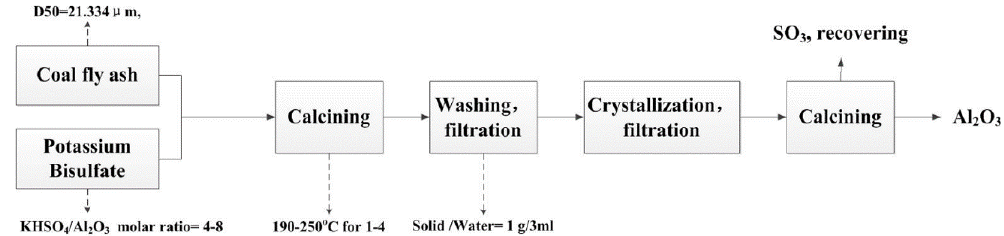
Figure 1. Flow diagram of the new calcination method for alumina extraction from coal fly ash (CFA).